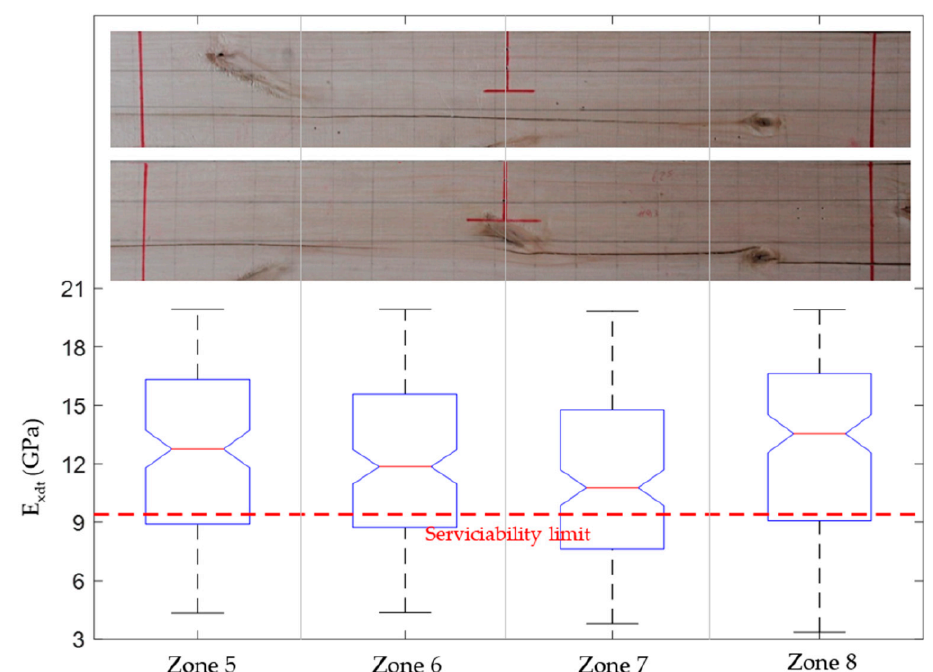
Figure 20. Boxplots of the four input factors located in the central third of the timber board # 28 ( E xdt in zones 5 to 8) for B sets. The pictures show the back and front of the lumber board in zones 5 to 8. The scatter plots in Figures 12, 15 and 18 allowed visualizing the general distribution of E xdt values in sets B and NB for different structural quality timber boards. As